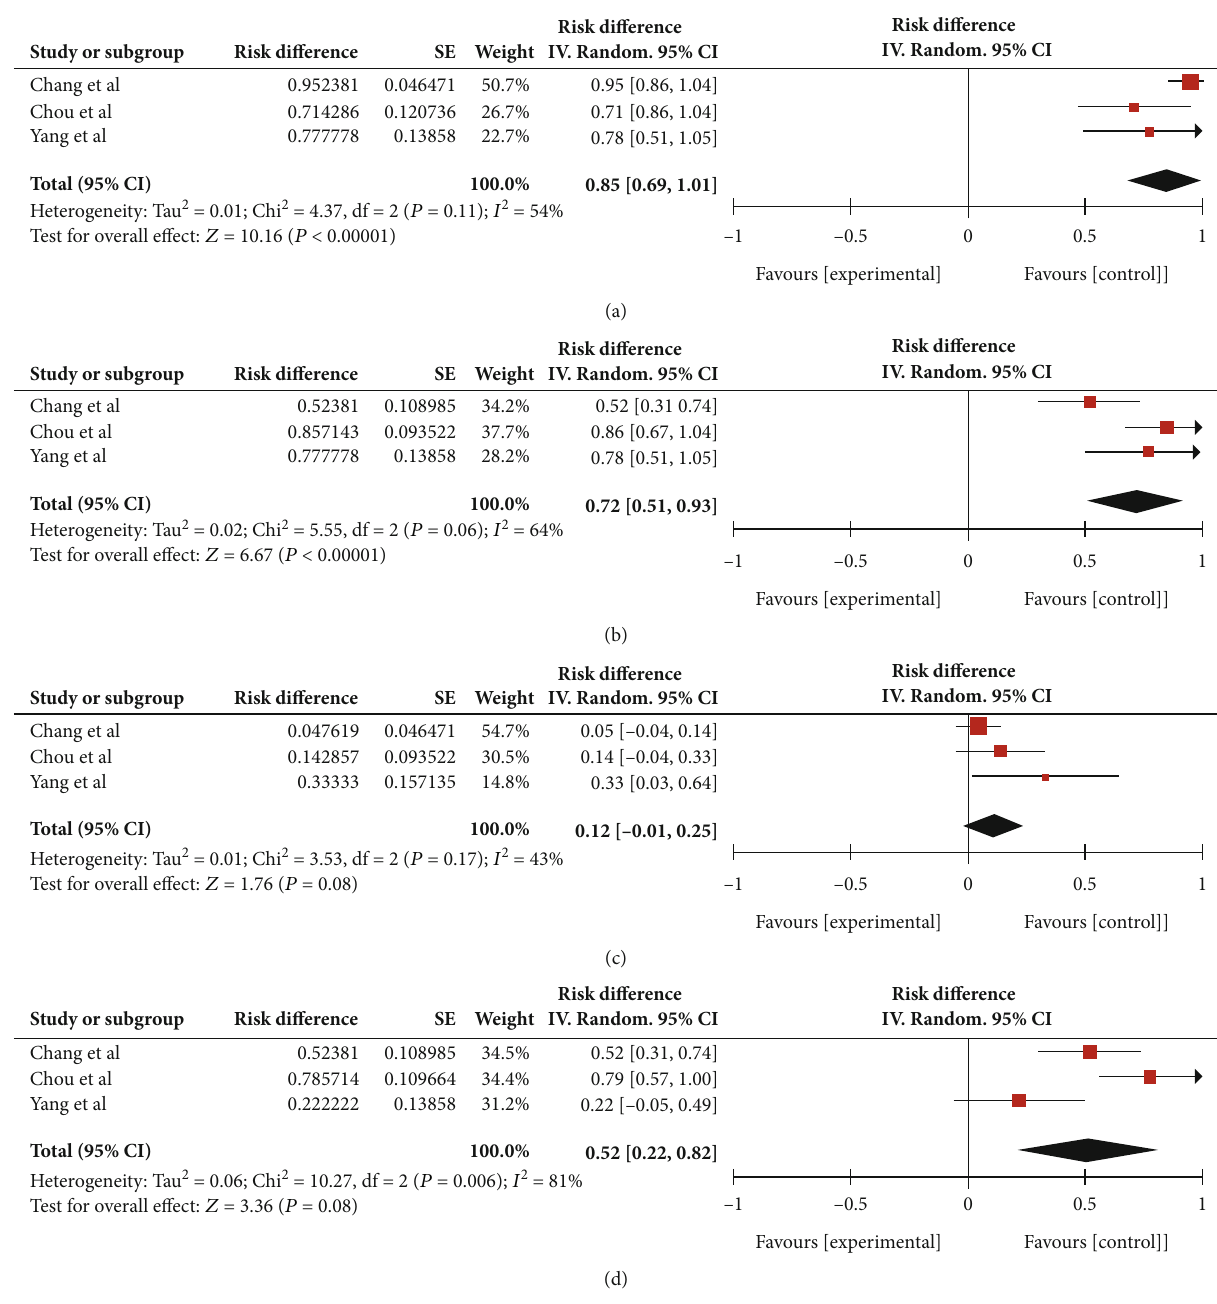
Figure 3: The clinical and imaging features of SPE. (a) 85% patients with SPE were male (95% CI, 69% – 101%). There was fair and moderate heterogeneity ( p = 0 : 11 , I 2 = 54 % ). (b) 72% patients with SPE had diabetes mellitus (95% CI, 51% – 93%). There was considerable and substantial heterogeneity ( p < 0 : 10 , I 2 = 64 % ). (c) The pooled mortality rate of Klebsiella pneumoniae liver abscess (KPLA) with SPE